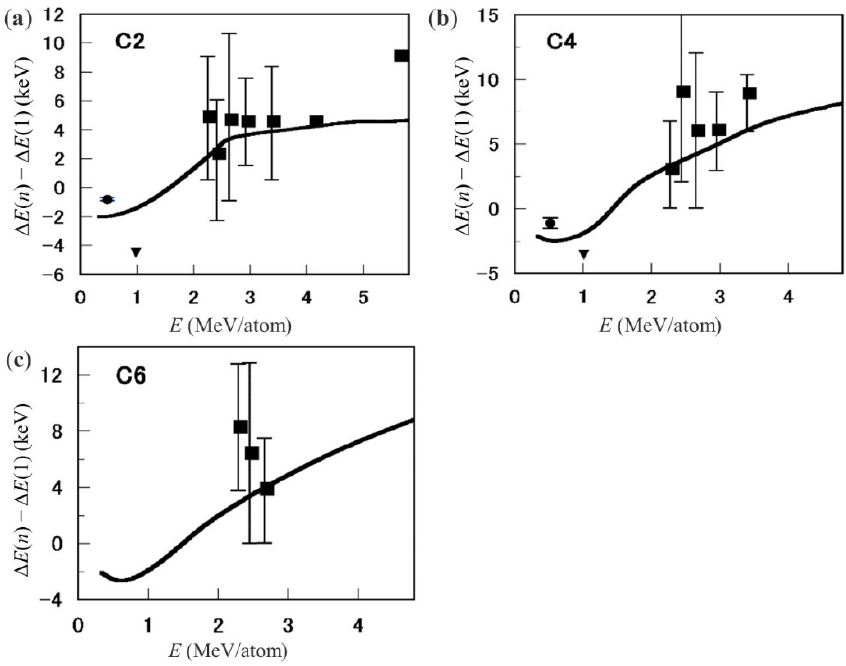
+ + + , ( b ) 4 C and ( c ) 6 C cluster 0 thickness. Solid lines are